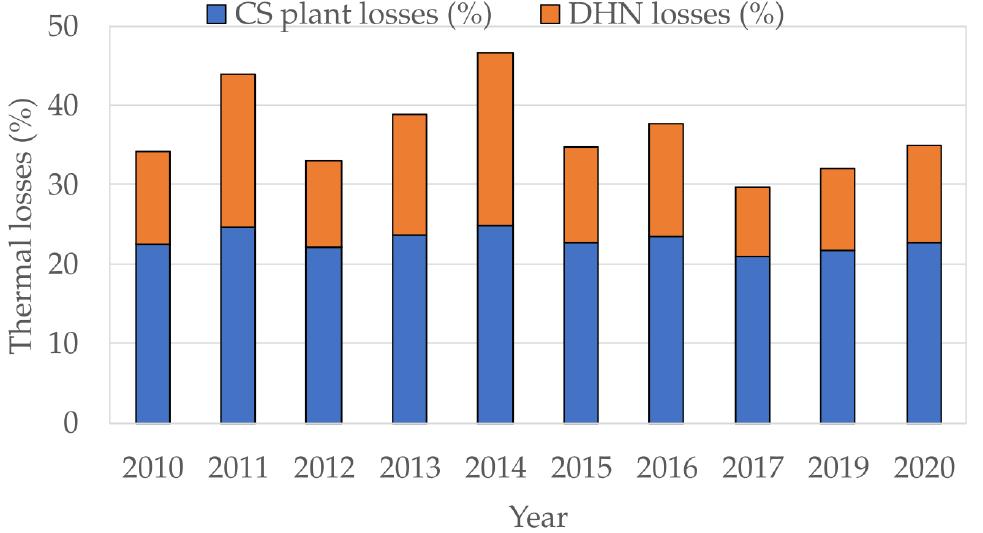
Figure 3. Thermal losses due to CS plant management and the